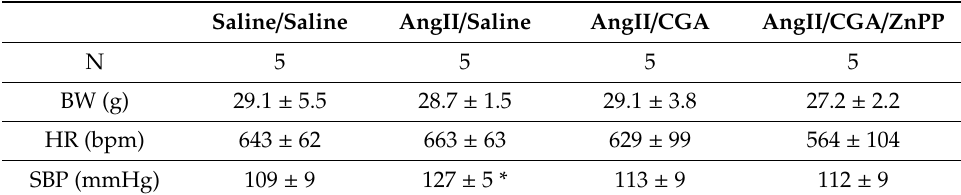
Table 2. Characteristics of the study